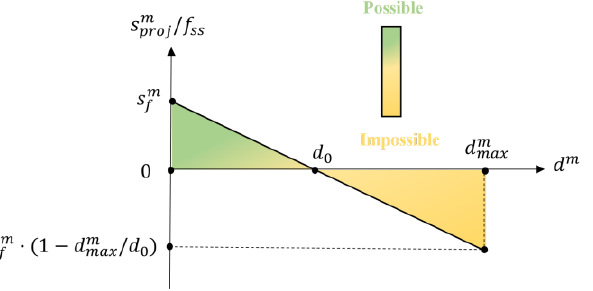
Figure 12. The scaled score divided by 𝑓 𝑠𝑠 versus the distance from the 𝑚 -th face center to the anchor is drawn according to (8). The higher the scaled score is, the more likely the sliding window is to contain a human body.